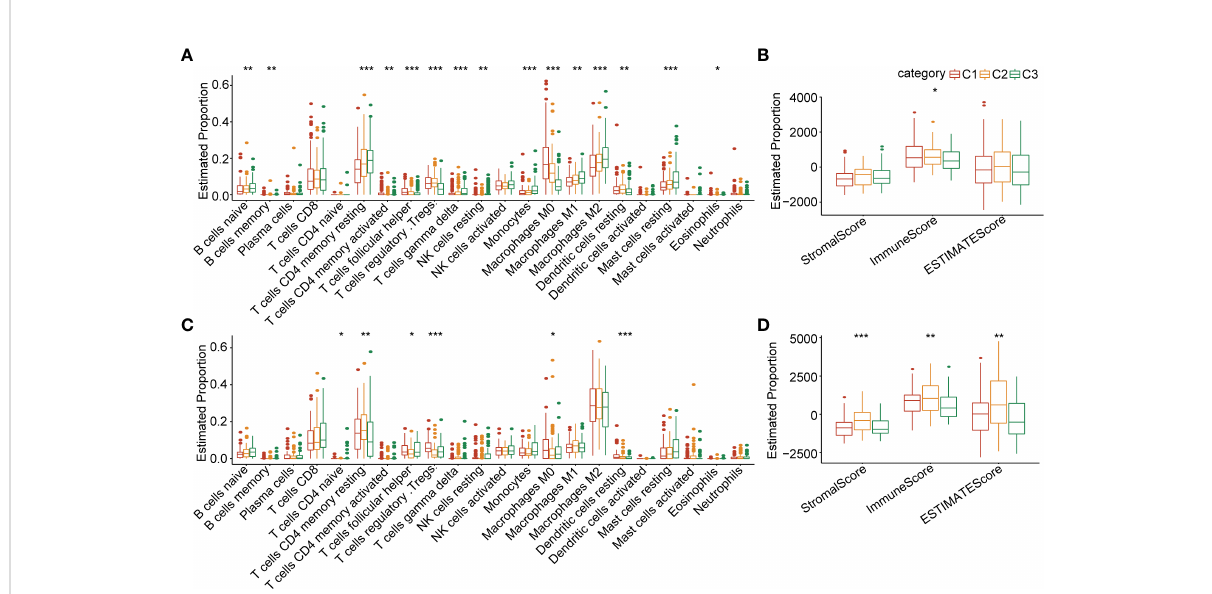
FIGURE 4 Comparisons of immune cell in fi ltration level in 3 clusters (A) The in fi ltration levels of 22 immune cell types between 3 clusters in the TCGA- LIHC cohort. (B) The ESTIMATE proportion of stromal score, immune score, and ESTIMATE score between 3 clusters in the TCGA-LIHC cohort. (C) The in fi ltration level of 22 immune cell types between 3 clusters in the ICGC cohort. (D) The ESTIMATE proportion of stromal score, immune score, and ESTIMATE score between 3 clusters in the ICGC cohort. *P<0.05; **P<0.01;